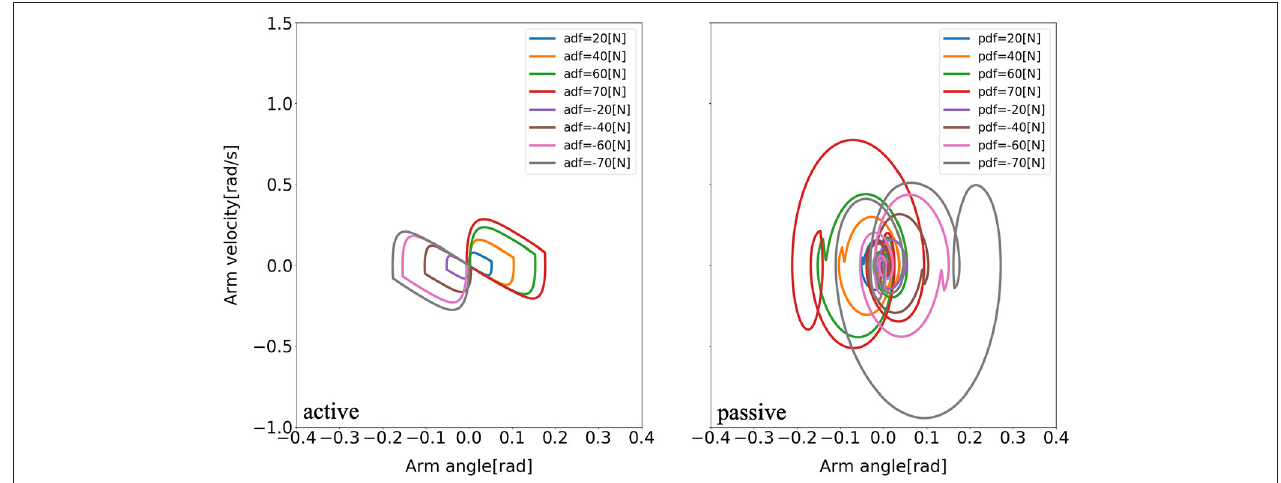
FIGURE 11 | Evolution of the arm phase portrait of the model for two different arm states (active arm, passive arm) for different disturbing forces: (1) Push backward: − 20 [ N ], − 40 [ N ], − 60 [ N ], and − 70 [ N ]. (2) No force: 0 [ N ]. (3) Push forward: 20 [ N ], 40 [ N ], 60 [ N ], and 70 [ N ]. “a” and “p” in the labels “adf” and “pdf” represent the cases with active arms and passive arms, respectively, and “df” represents the disturbing forces.